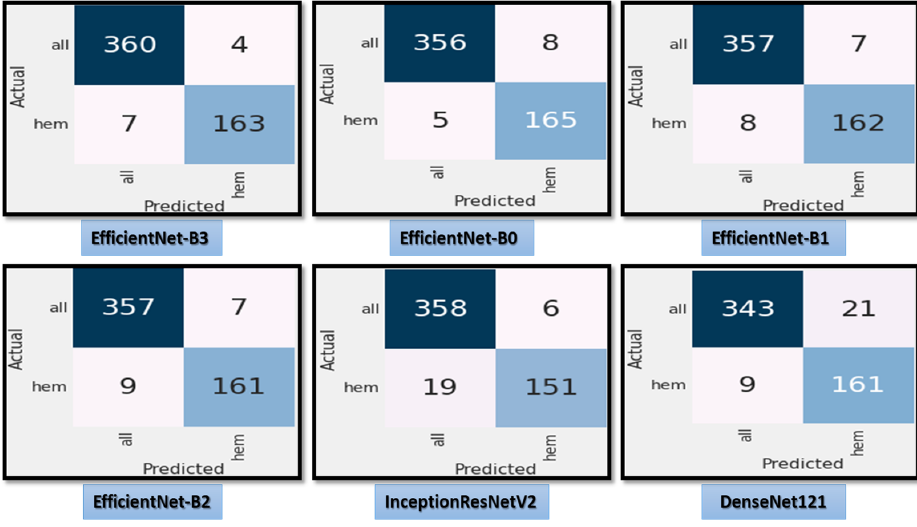
Figure 9. The test dataset’s confusion matrix for the six CNN models using dynamic LR.